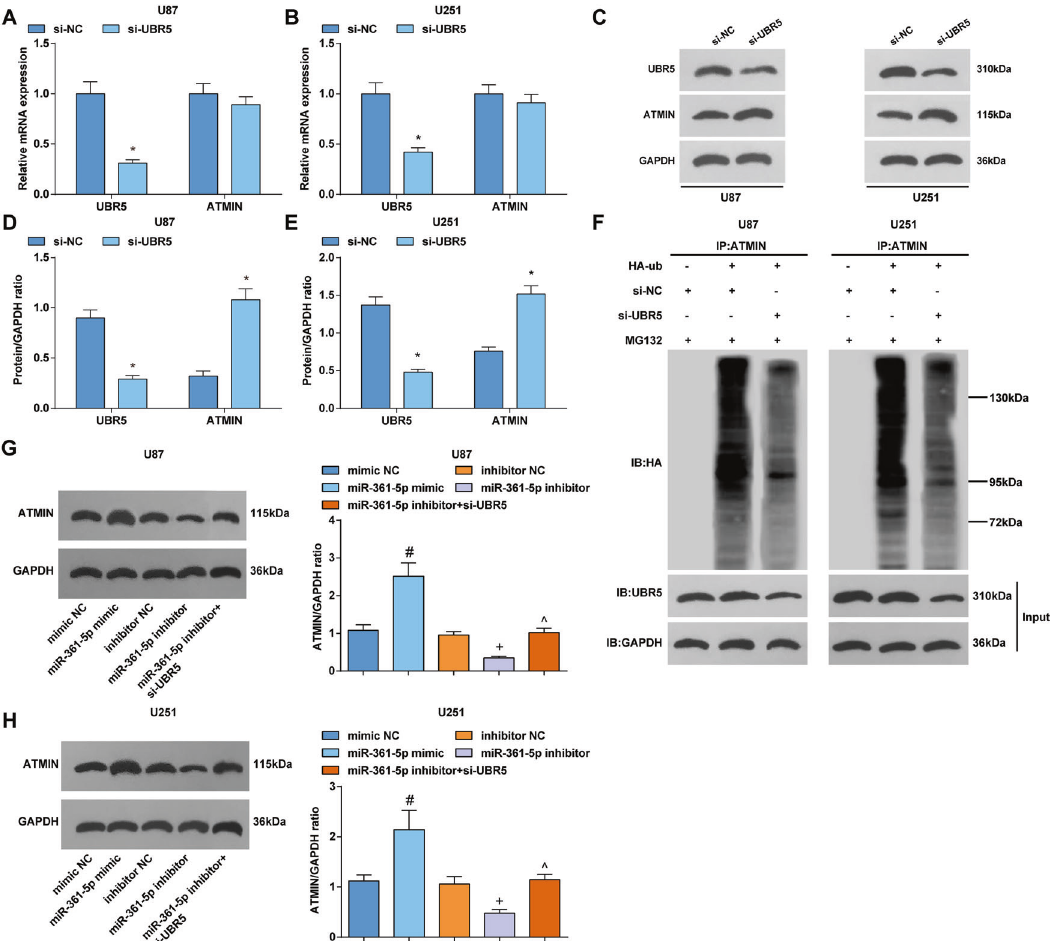
Fig. 5 UBR5 regulates ubiquitination of ATMIN. A RT-qPCR tested UBR5 and ATMIN mRNA expression in U87 cells. B RT-qPCR tested UBR5 and ATMIN mRNA expression in U251 cells. C Western blot tested UBR5 and ATMIN protein bands in U87 and U251 cells. D Western blot tested UBR5 and ATMIN protein expression in U87 cells. E Western blot tested UBR5 and ATMIN protein expression in U251 cells. F Cells were treated with HA-labeled ubiquitin and transfected with siRNA, cells were treated with proteasome inhibitor MG132 (MG) for 2 h before lysis in denaturing buffer. Immunoprecipitation determined the ubiquitination of ATMIN. G , H Western blot detected ATMIN protein expression in U87 and U251 cells. The data were all measurement data, in the form of mean ± standard deviation; * P < 0.05 compared with the si-NC group; # P < 0.05 compared with the mimic NC group; + P < 0.05 compared with the inhibitor NC group; ^ P < 0.05 compared with the miR-361-5p inhibitor